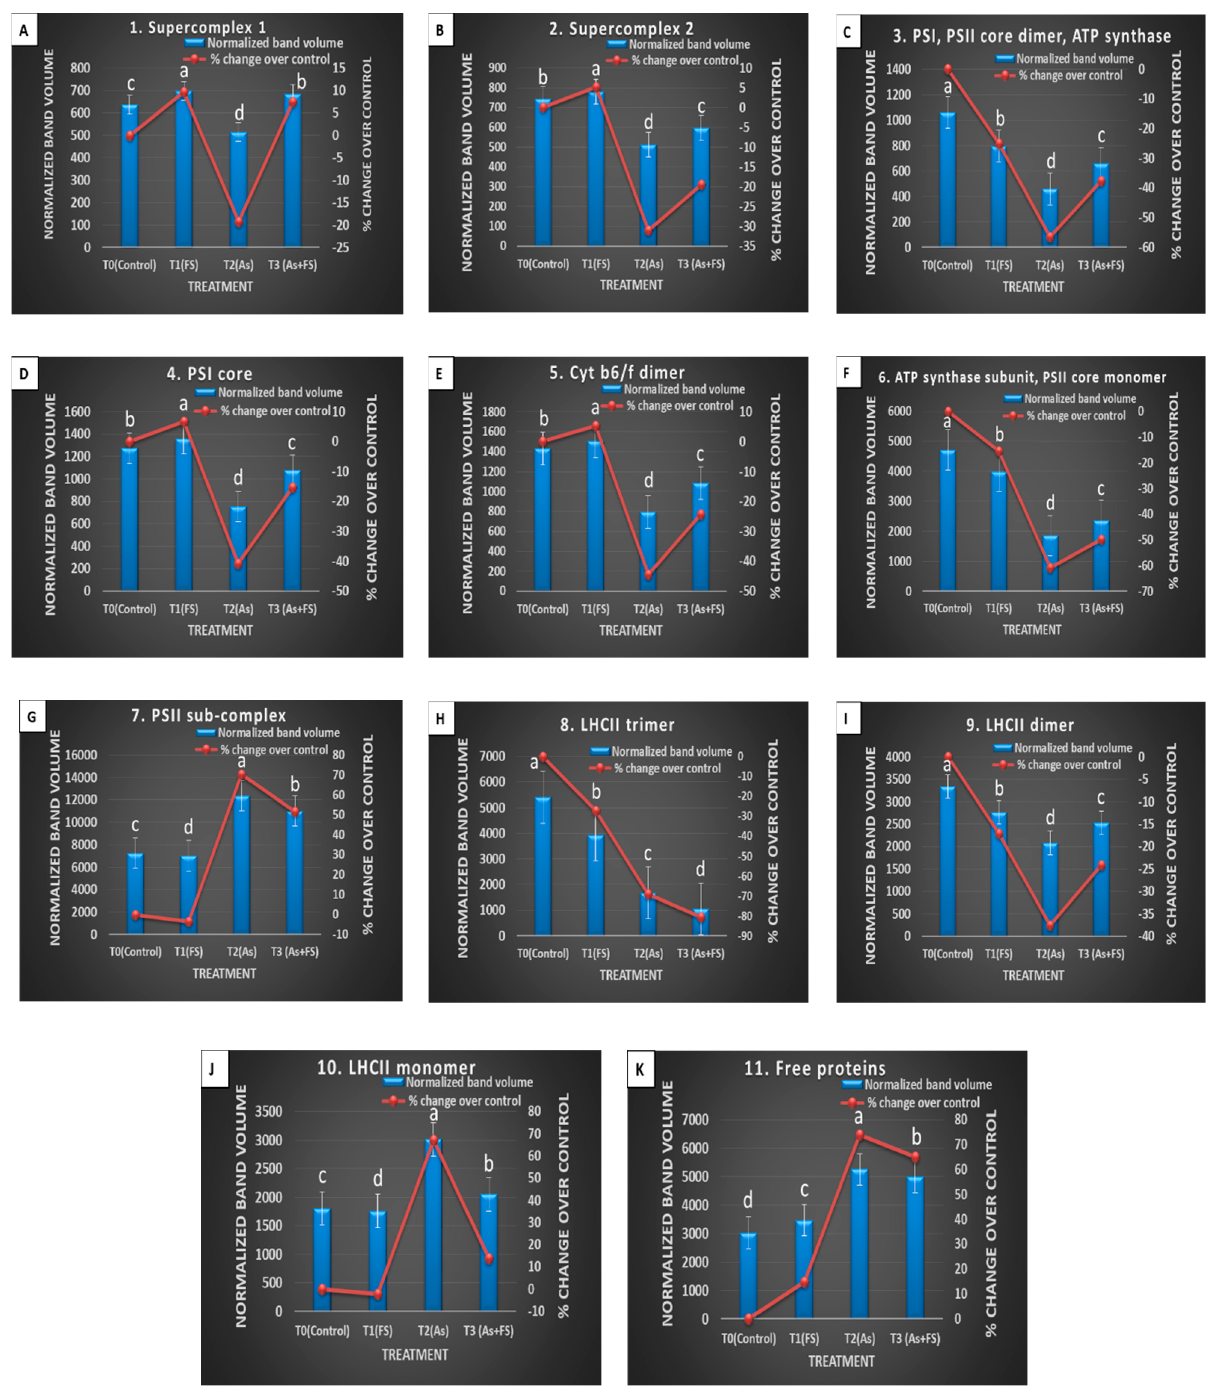
Figure 10. ( A – K ): BN-PAGE (1st dimension) gel’s band volume analysis of ( A ) Band 1 , ( B ) Band 2 , ( C ) Band 3 , ( D ) Band 4 , ( E ) Band 5 , ( F ) Band 6 , ( G ) Band 7 , ( H ) Band 8 , ( I ) Band 9 , ( J ) Band 10 , and ( K ) Band 11 mediated by ImageLab software, depicting changes in membrane protein complexes of Brassica juncea . The left Y -axis depicts normalized band volume and the right Y -axis depicts the % change of band volume of the treatments T1 (+FeSO 4 ), T2 (+As), and T3 (As + FeSO 4 ) over control at 14 DAT. The values are mean ± SE and n = 3. Different letters on the bars indicate significant changes ( p < 0.05) in different treatments as determined by Tukey’s HSD test. As, Arsenic; FS, FeSO 4 .